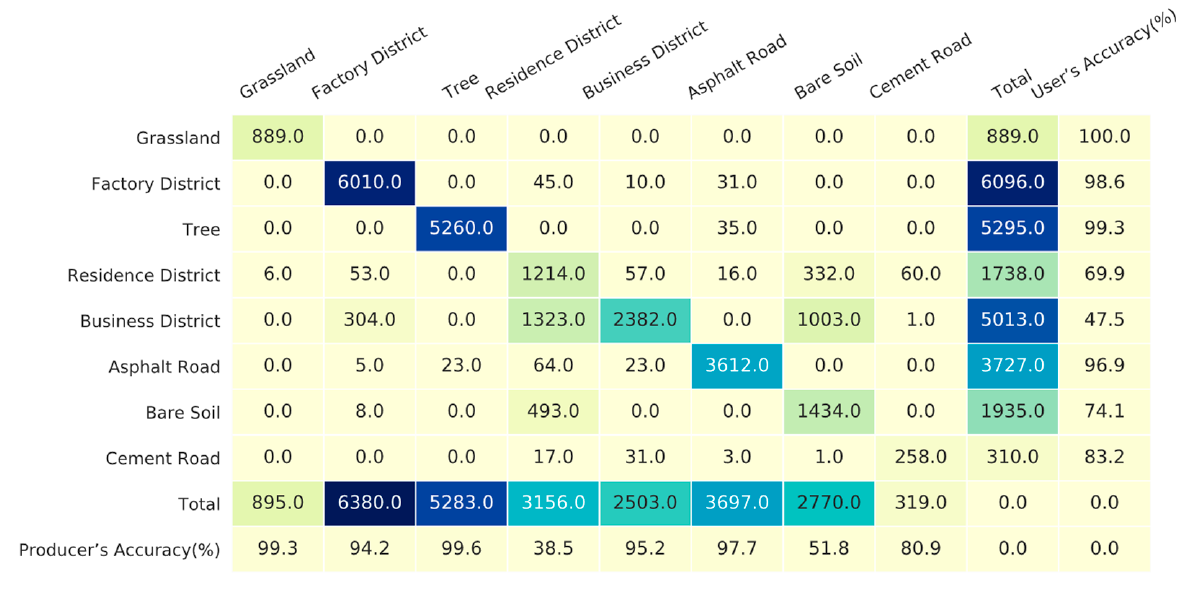
Figure 9. Confusion matrix of the classification results derived when 700-angle images were selected as the input data.